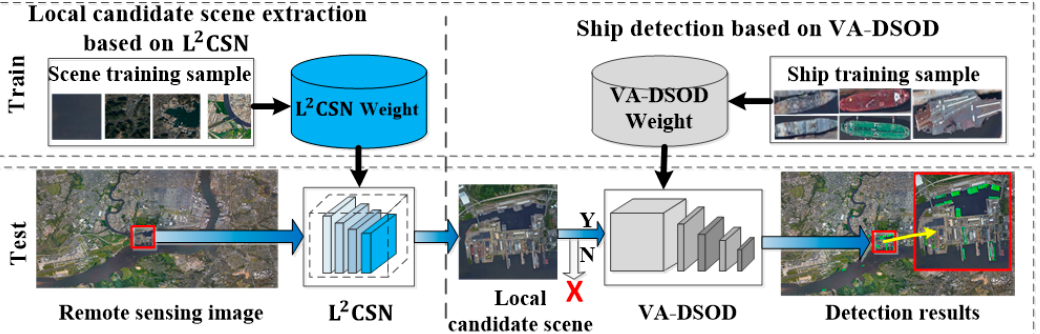
Figure 1. The framework of the proposed method.